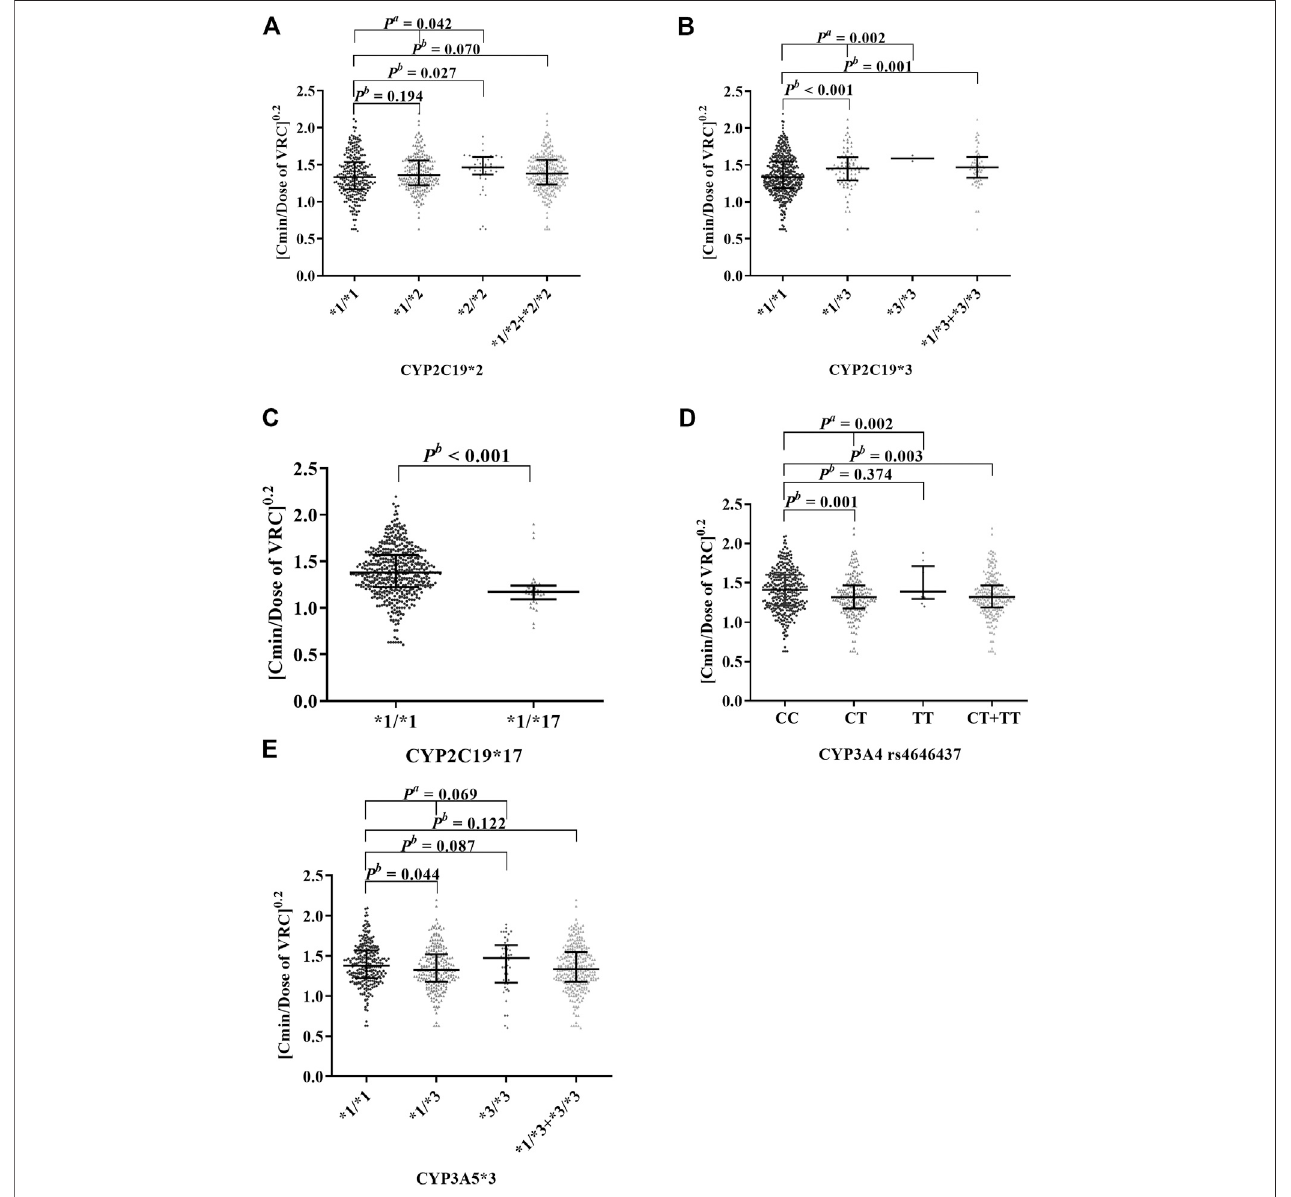
FIGURE2| EffectsofcytochromeP450polymorphismsontheC/DratioofVRC.Thedatawerenon-normaldistributionandexpressedasmedianwithinterquartile range. The ordinate (C/D ratio of VRC) was processed to the power of 0.2. Data showed in Supplemental Table S3 . (A) showed that the comparison between CYP2C19*1/*1 ( n (cid:2) 286), CYP2C19*1/*2 ( n (cid:2) 228), and CYP2C19*2/*2 ( n (cid:2) 41) was signi fi cant ( p a (cid:2) 0.042). (B) showed that the CYP2C19*1/*3 + CYP2C19*3/*3 ( n (cid:2) 83)canincreasetheC/DratioofVRCsigni fi cantlycomparedto CYP2C19*1/*1 ( n (cid:2) 472, p b (cid:2) 0.001). (C) showedthatthe CYP2C19*1/*1 7( n (cid:2) 35)canreduce theC/DratioofVRCsigni fi cantlycomparedto CYP2C19*1/*1 ( n (cid:2) 520, P b < 0.001). (D) showedthatthecomparisonbetween CYP3A4 genotypeCC( n (cid:2) 338)andCT+ TT( n (cid:2) 217)hadstatisticaldifferences( P b (cid:2) 0.003).(E)showedthatthecomparisonbetween CYP3A5*1/*1 ( n (cid:2) 267), CYP3A5*1/*3 ( n (cid:2) 240),and CYP3A5*3/*3 ( n (cid:2) 48) was insigni fi cant ( P a (cid:2)